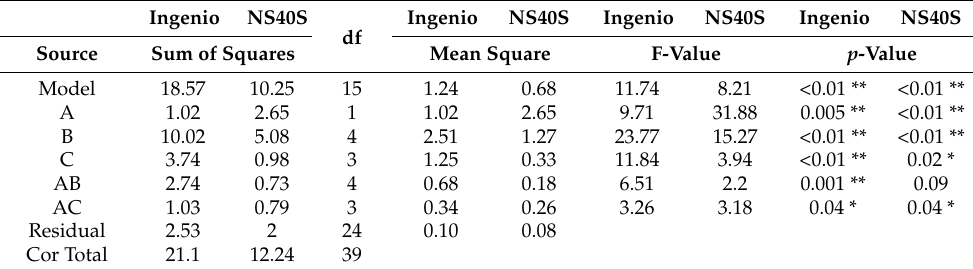
Table 5. ANOVA table for the 2018 grain yield dataset.